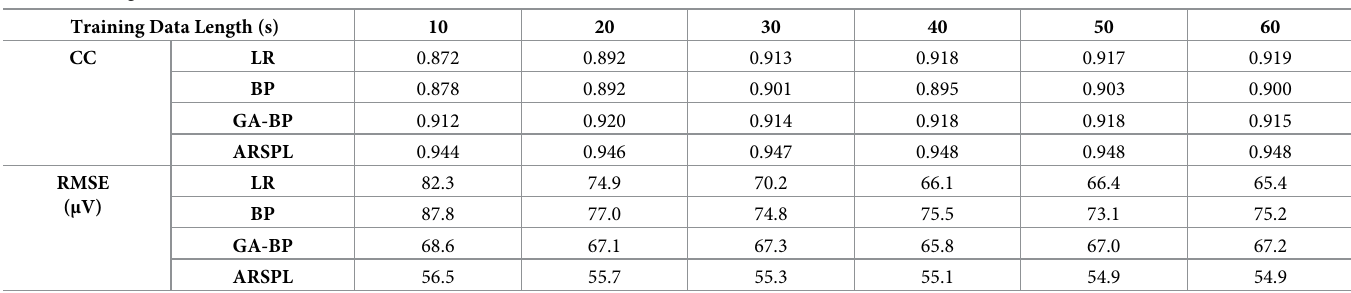
Table 2. Average CC and RMSE of the four